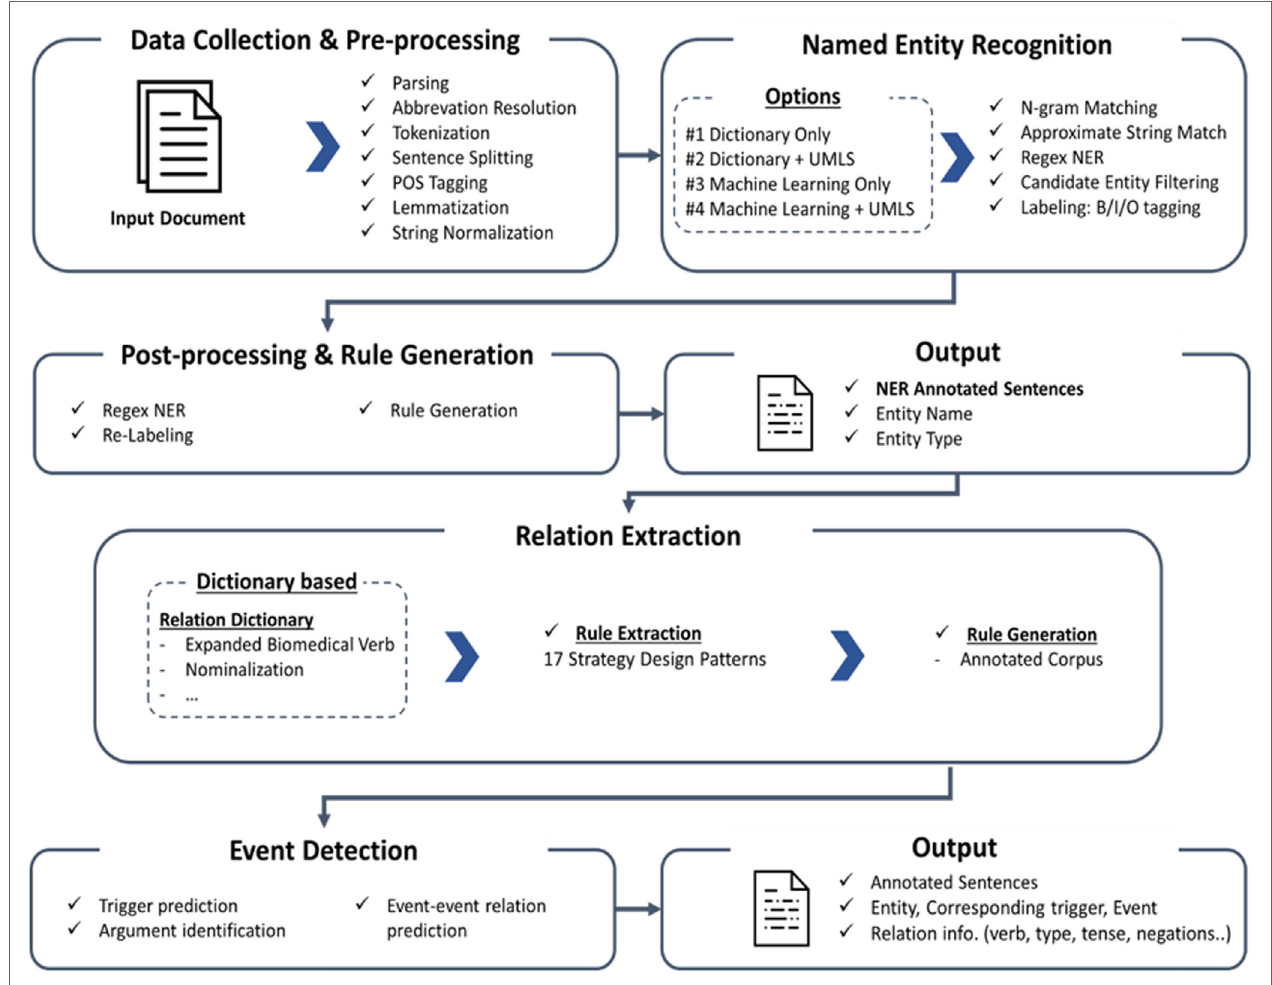
FigUre 1 | Overall architecture of the new version of